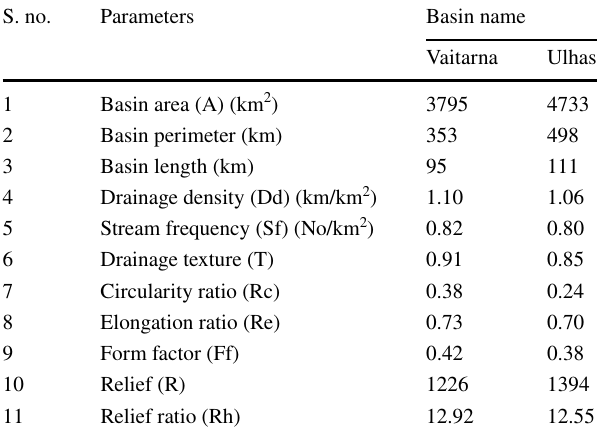
Table 3 Results showing variation of basin morphometric properties of Vaitarna and Ulhas basins